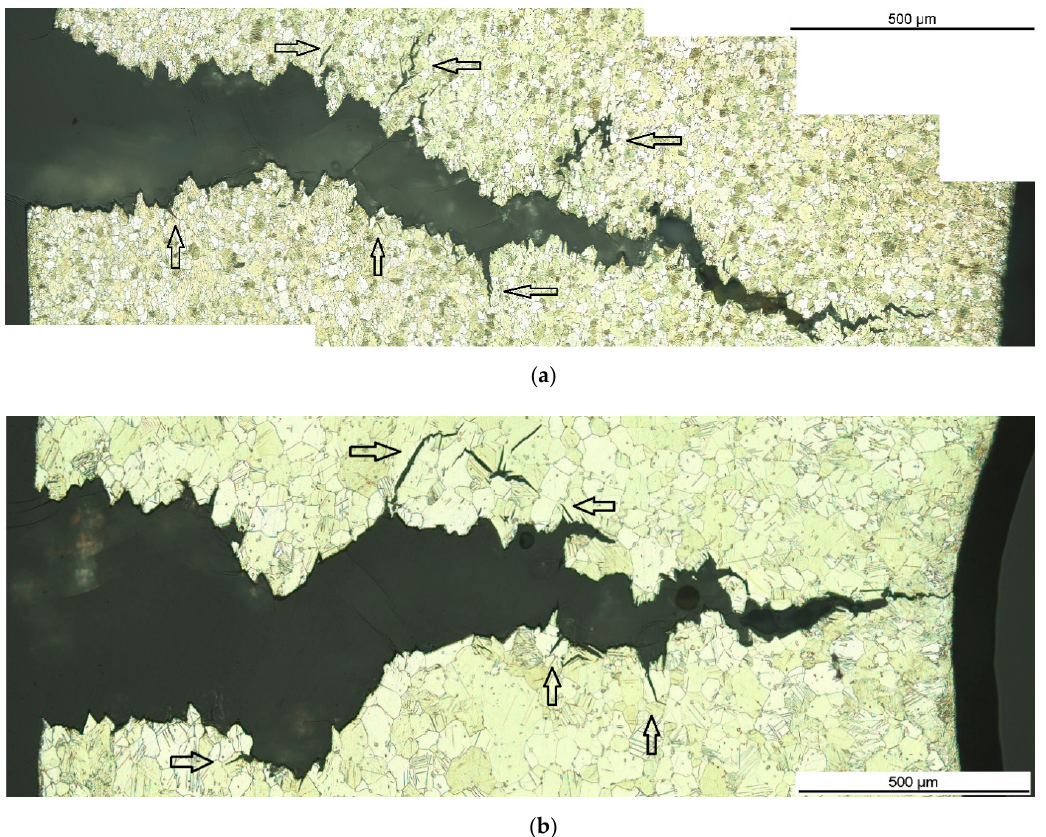
Figure 2. Representative cross ‐ sectional optical micrographs of the crack path in the Mg ‐ Dy ‐ Nd ‐ Zn ‐ Zr alloy C ‐ ring samples for the fine ‐ grained microstructure: heat ‐ treated at 200 °C for 4 h ( a ) and for the coarser ‐ grained microstructure: solution heat ‐ treated at 500 °C for 24 h ( b ).